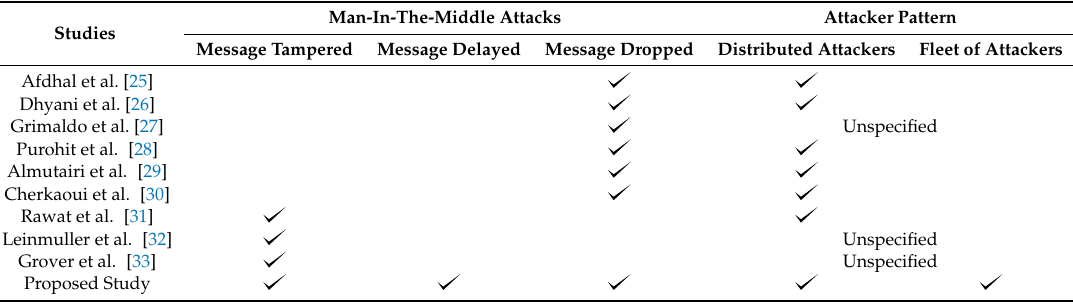
Table 1. Comparison of Different Studies on MITM Attacks in